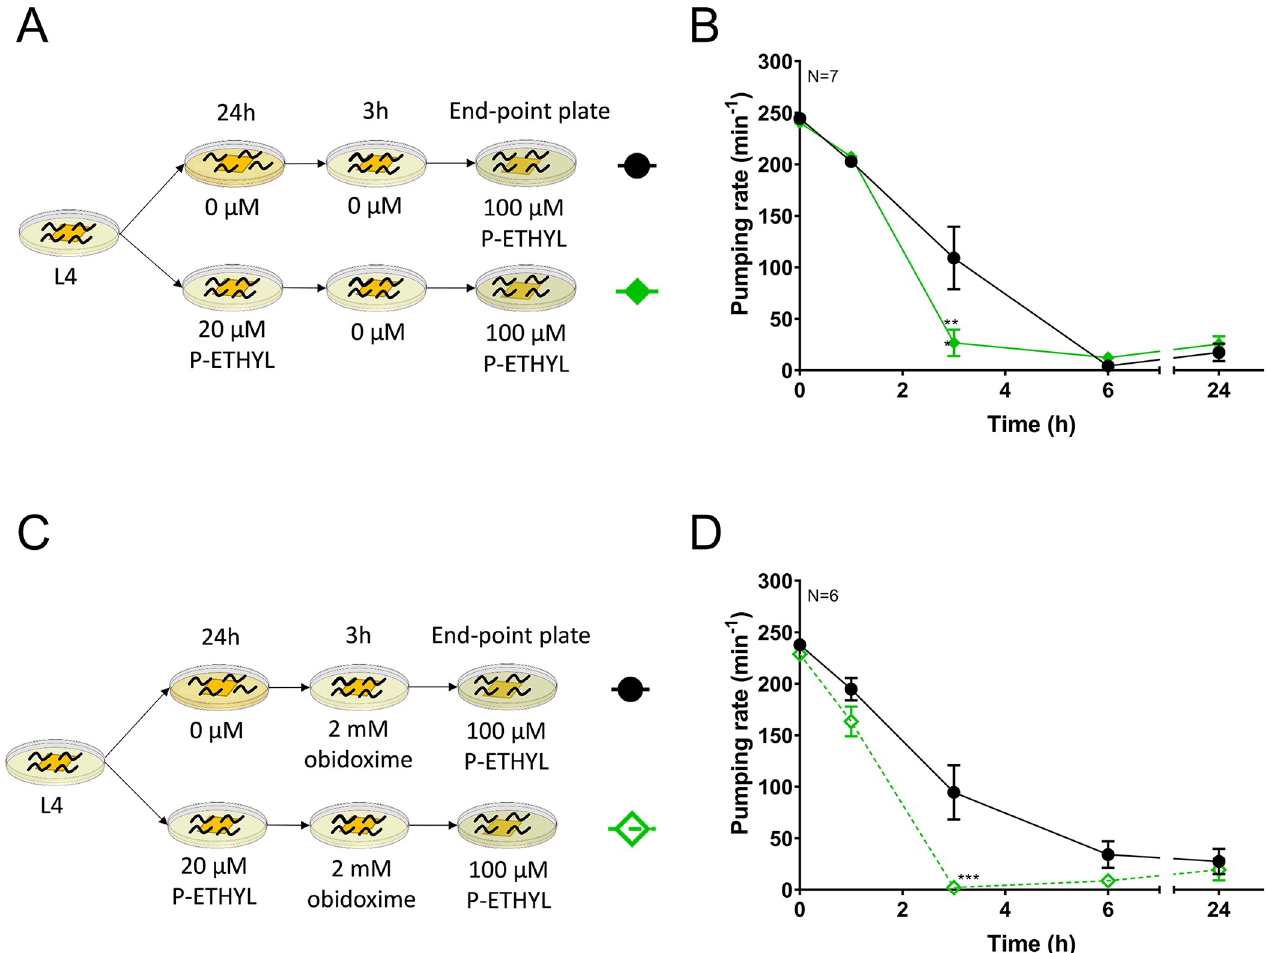
Fig 2. Nematodes preconditioned with paraoxon-ethyl are sensitized to subsequent organophosphate inhibition of pharyngeal pumping. A) Synchronized L4 worms were incubated on either non-drug or 20 μ M paraoxon-ethyl containing plates. After 24 hours, they were transferred to non-drug containing plates to allow the recovery of pharyngeal function. They were transferred to plates containing 100 μ M paraoxon-ethyl where the pharyngeal pumping was scored. B) Paraoxon-ethyl-preconditioned nematodes exhibited a greater reduction of the pharyngeal pumping following transfer to 100 μ M paraoxon-ethyl plates compared to the non-preconditioned animals. Data are shown as mean ± SEM of 7 worms in at least 4 independent experiments (N = 7). C) Nematodes were preconditioned as indicated in A, however, obidoxime was added to the recovery plate to promote the rescue of the acetylcholinesterase activity after paraoxon-ethyl inhibition. D) Preconditioned nematodes exhibited a similar response to maximal dose of paraoxon-ethyl when they were allowed to recover in the presence or in the absence of obidoxime. Data are shown as mean ± SEM of 6 worms in at least 3 independent experiments (N = 6). Statistical significance between preconditioned and non-preconditioned nematodes was calculated by two-way ANOVA test followed by Bonferroni corrections. *** p �